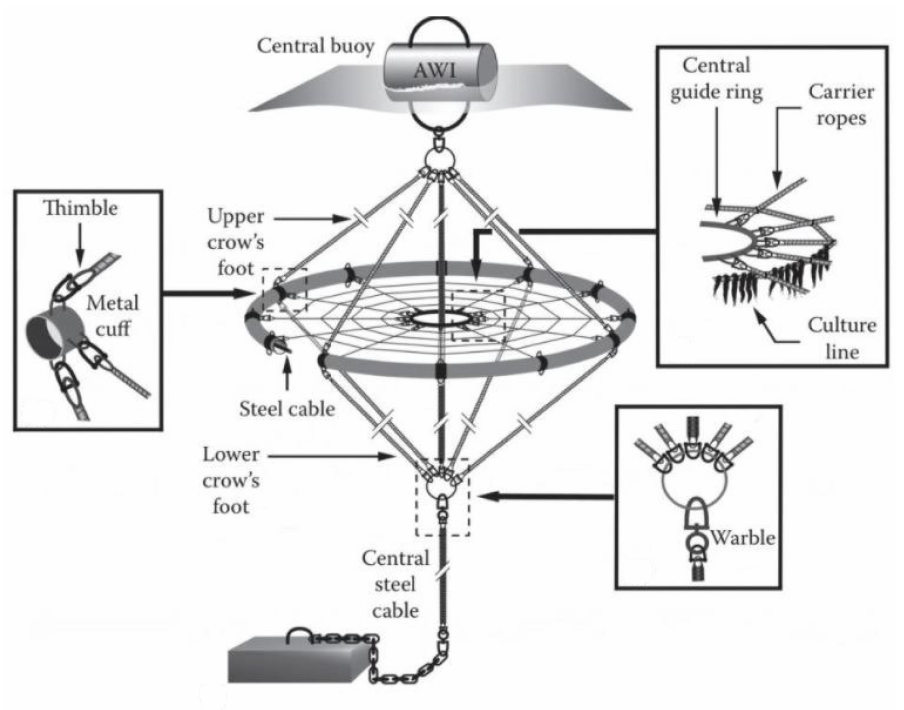
Figure 8. Circular sub-surface ring structure